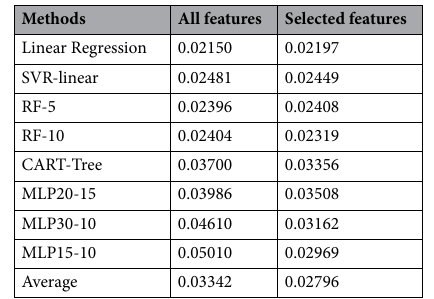
Table 3. Forecast mean absolute percentage error comparison for selected methods.